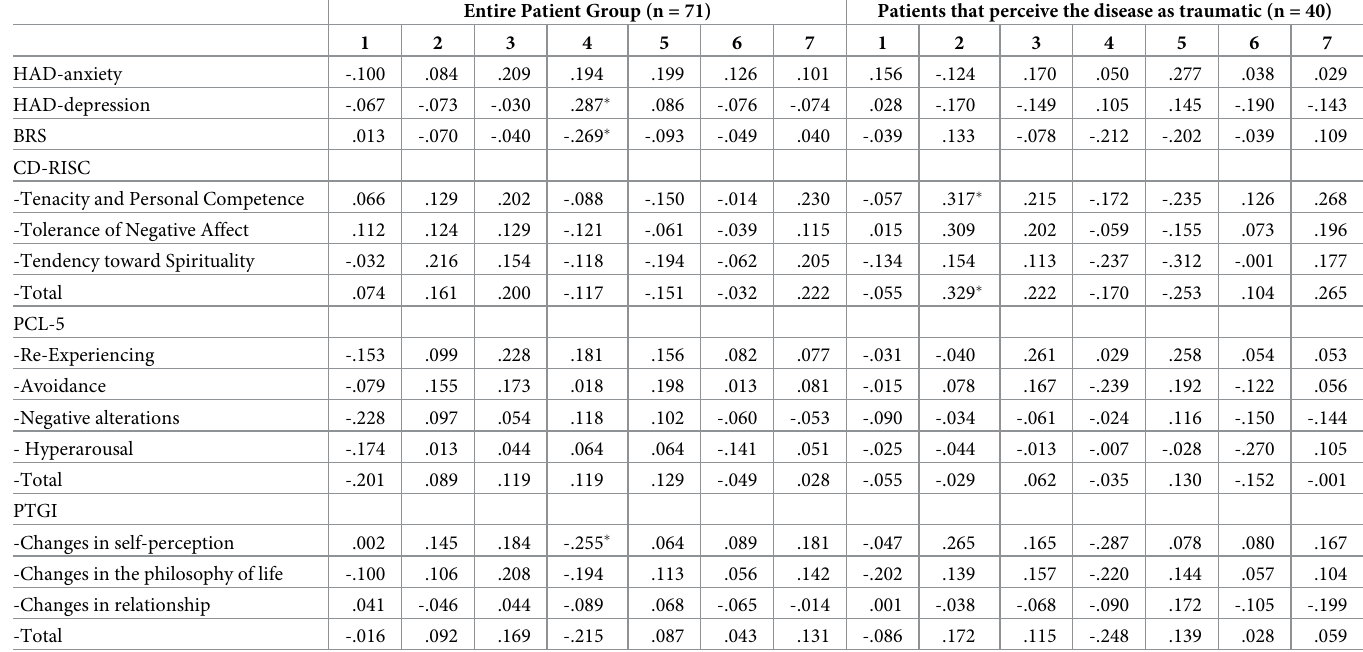
Table 4. The relationship between possible biomarkers and study scale